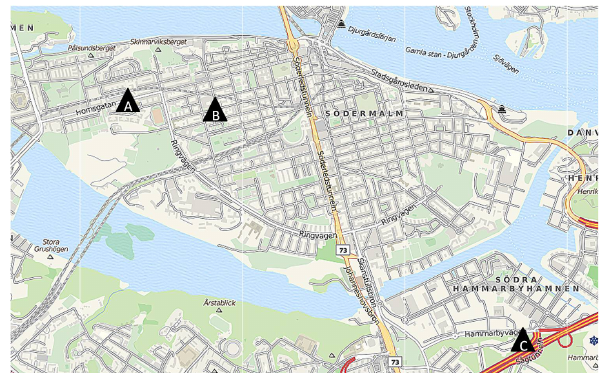
Fig. 1. Location of the monitoring stations in Stockholm: Horns- gatan (A) , Torkel Knutssonsgatan (B) and Kalmgatan (C) Blue in- dicates water surfaces, green forest/park areas, grey built-up areas and red yellow important